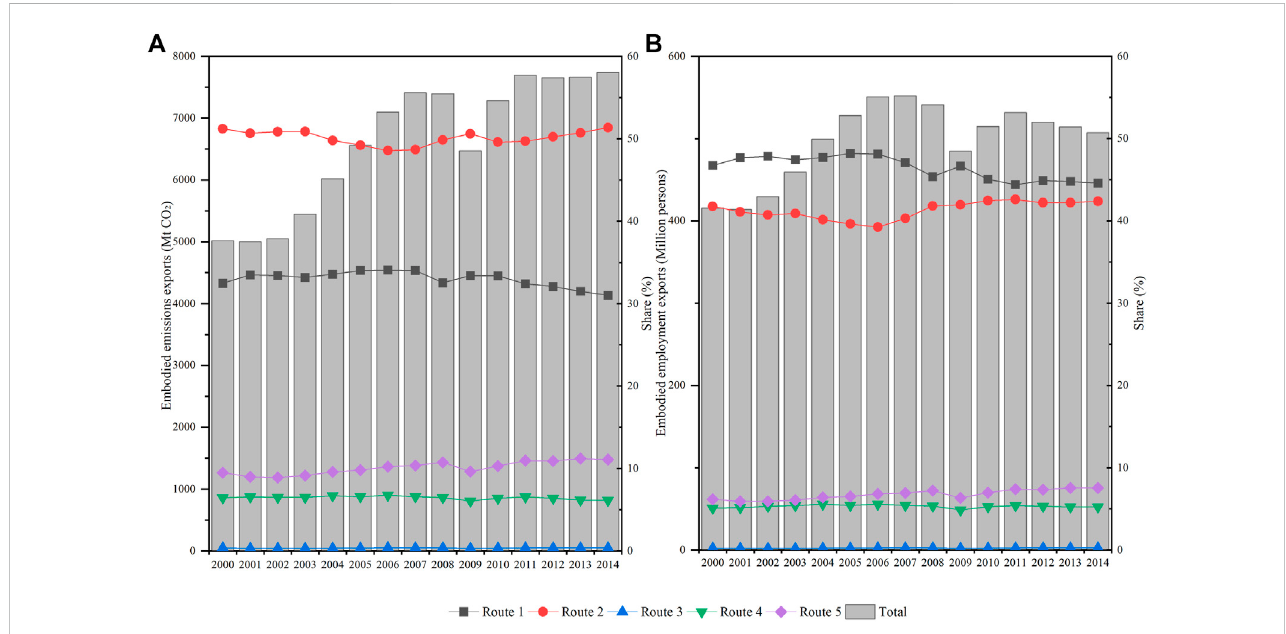
FIGURE 2 Domestic emissions (A) and employment (B) driven by foreign fi nal demand and their share of export